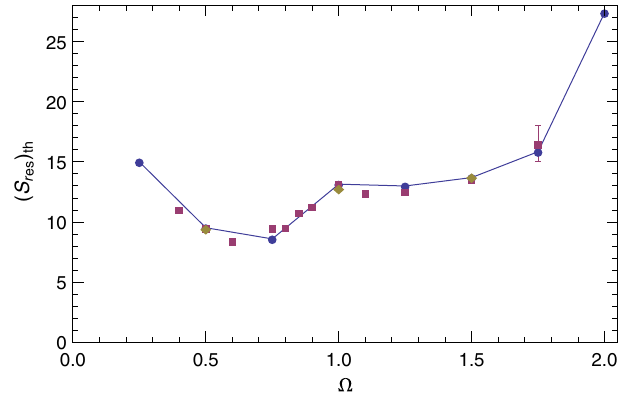
FIG. 1. For the Q ¼ 1 resonator wake, threshold value of S res vs parameter (cid:4) . Symbols give results of the VFP solver (blue circles), the LV code (red squares), and the VFP solver with twice the damping parameter: (cid:5) ¼ 2 : 5 (cid:4) 10 (cid:1) 3 (olive dia- monds).